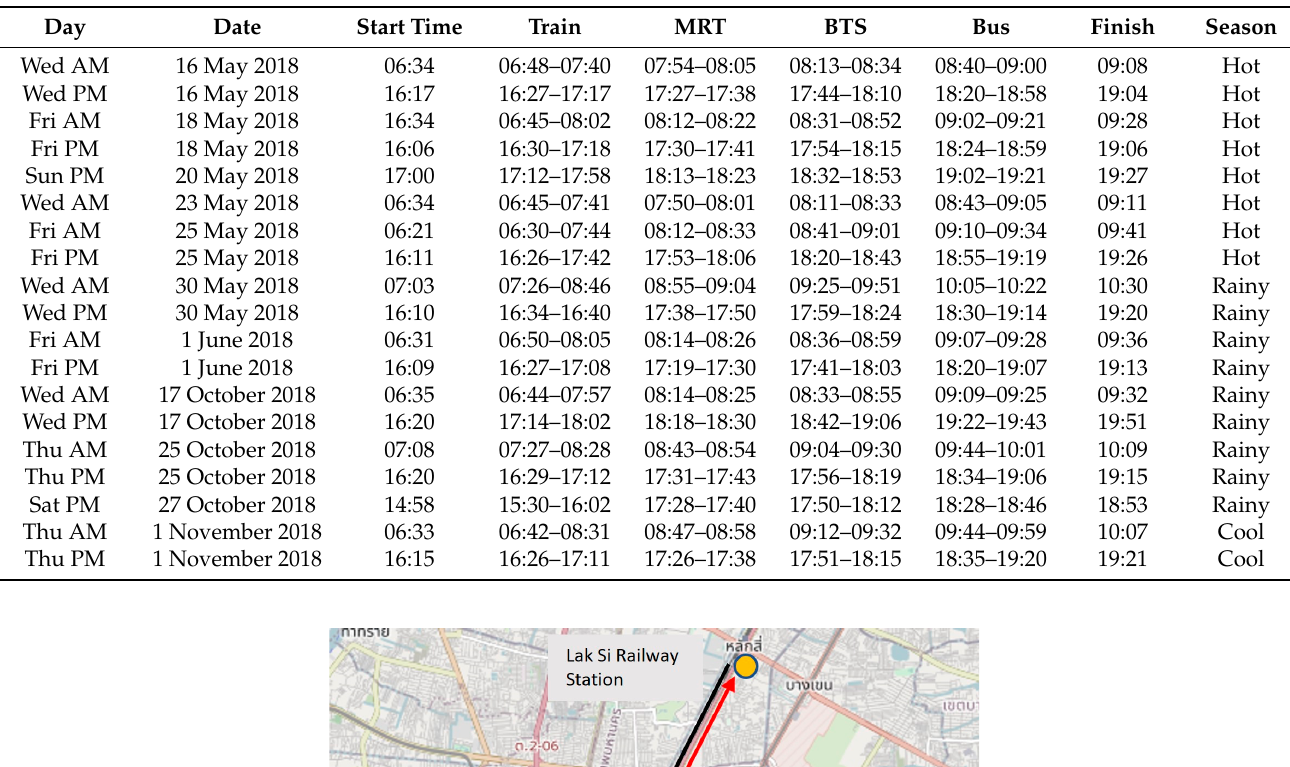
Table 1. Dates and times of measurements through the state railway (Train), Mass Rapid Transport underground system (MRT), BTS overground Skytrain (BTS) and Bus system. Times between ‘Start’ and ‘Finish’ are not included within each of the named transport modes which involved walking between different transport stations.